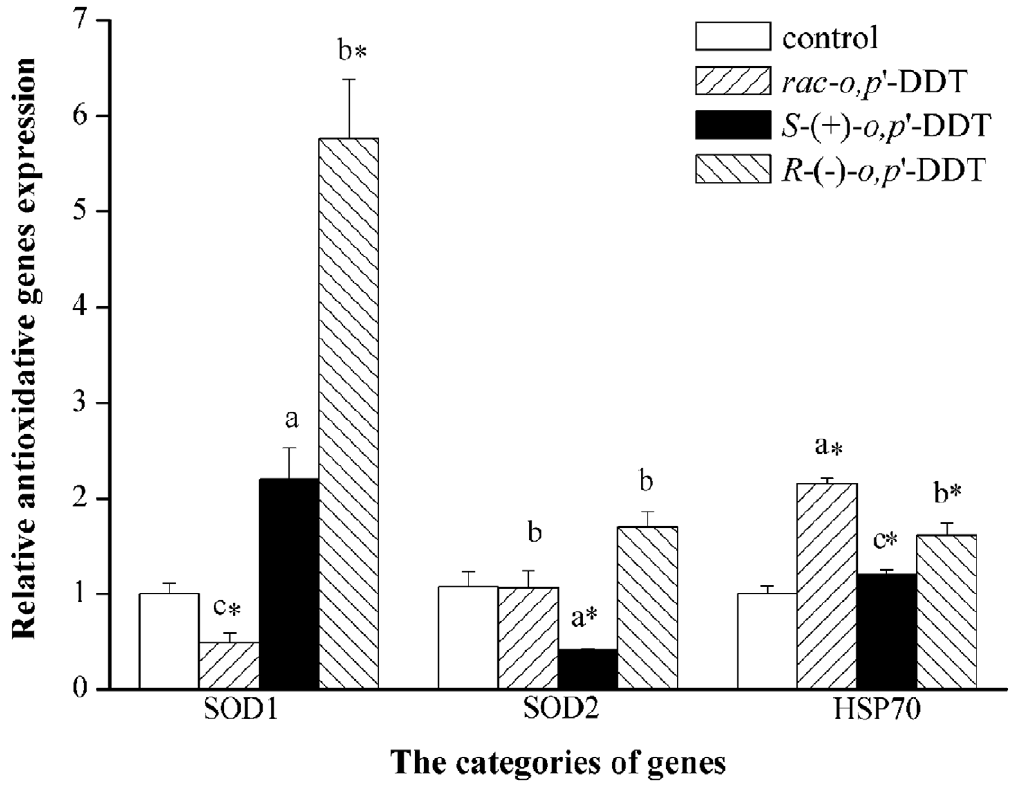
Figure 2. Oxidative stress related gene induction by racemate and enantiomers of o,p’ -DDT. The relative expression of anti-oxidative related genes encoding superoxide dismutase (SOD1 and SOD2) and heat shock protein (HSP) genes in response to racemate and enantiomers of o,p ’-DDT. The asterisk denoted p , 0.05 relative to the negative control. Different letters above adjacent bars indicate a significant difference ( p , 0.05) between individual enantiomers or between an enantiomer and racemate, while the same letter indicates no significant difference.